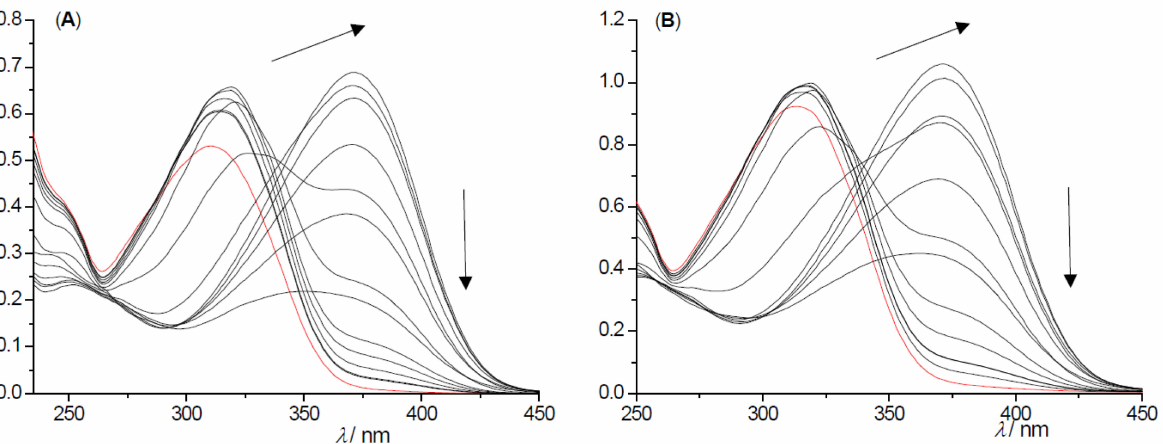
Figure 6. Spectral changes during the irradiation of cis - 6 ( A ) in ACN after 0 (red), 2, 4, 8, 16, 32, 64, 128, 256, 512, 1024, 2048 and 4096 s; ( λ ir = 313 nm, l = 1 cm) and trans - 6 ( B ) in ACN after 0 (red), 2, 4, 8, 16, 32, 64, 128, 256, 512, 1024 and 2048 s; ( λ ir = 313 nm, l = 1